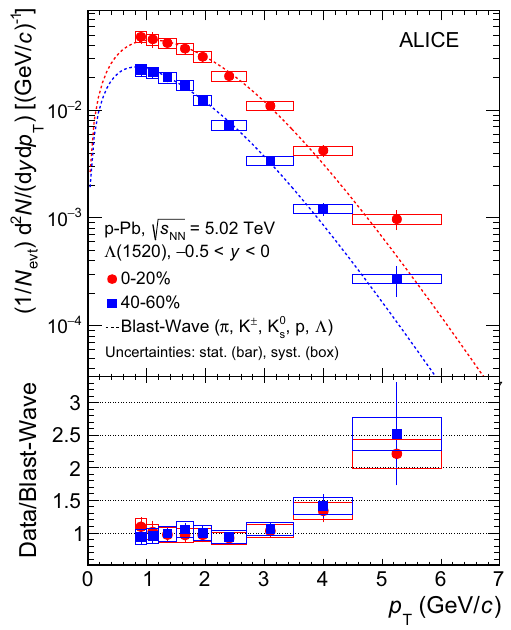
Fig. 6 The upper panel shows the p T distribution of (cid:3) ∗ in p–Pb col- √ s NN = 5 . 02 TeV in the 0–20% (red) and 40–60% (blue) lisions at multiplicity intervals. The dashed curves represent predictions from the Blast-Wave model [41], where the parameters are obtained from simultaneous fits to π ± , K ± , K 0 , p(p) and (cid:3) ( (cid:3) ) p T spectra and the S shapes are normalized to the data. The lower panel shows the ratios of the measured distributions to the values from the respective Blast- Wave functions. The statistical uncertainties are shown as bars and the systematic uncertainties are shown as